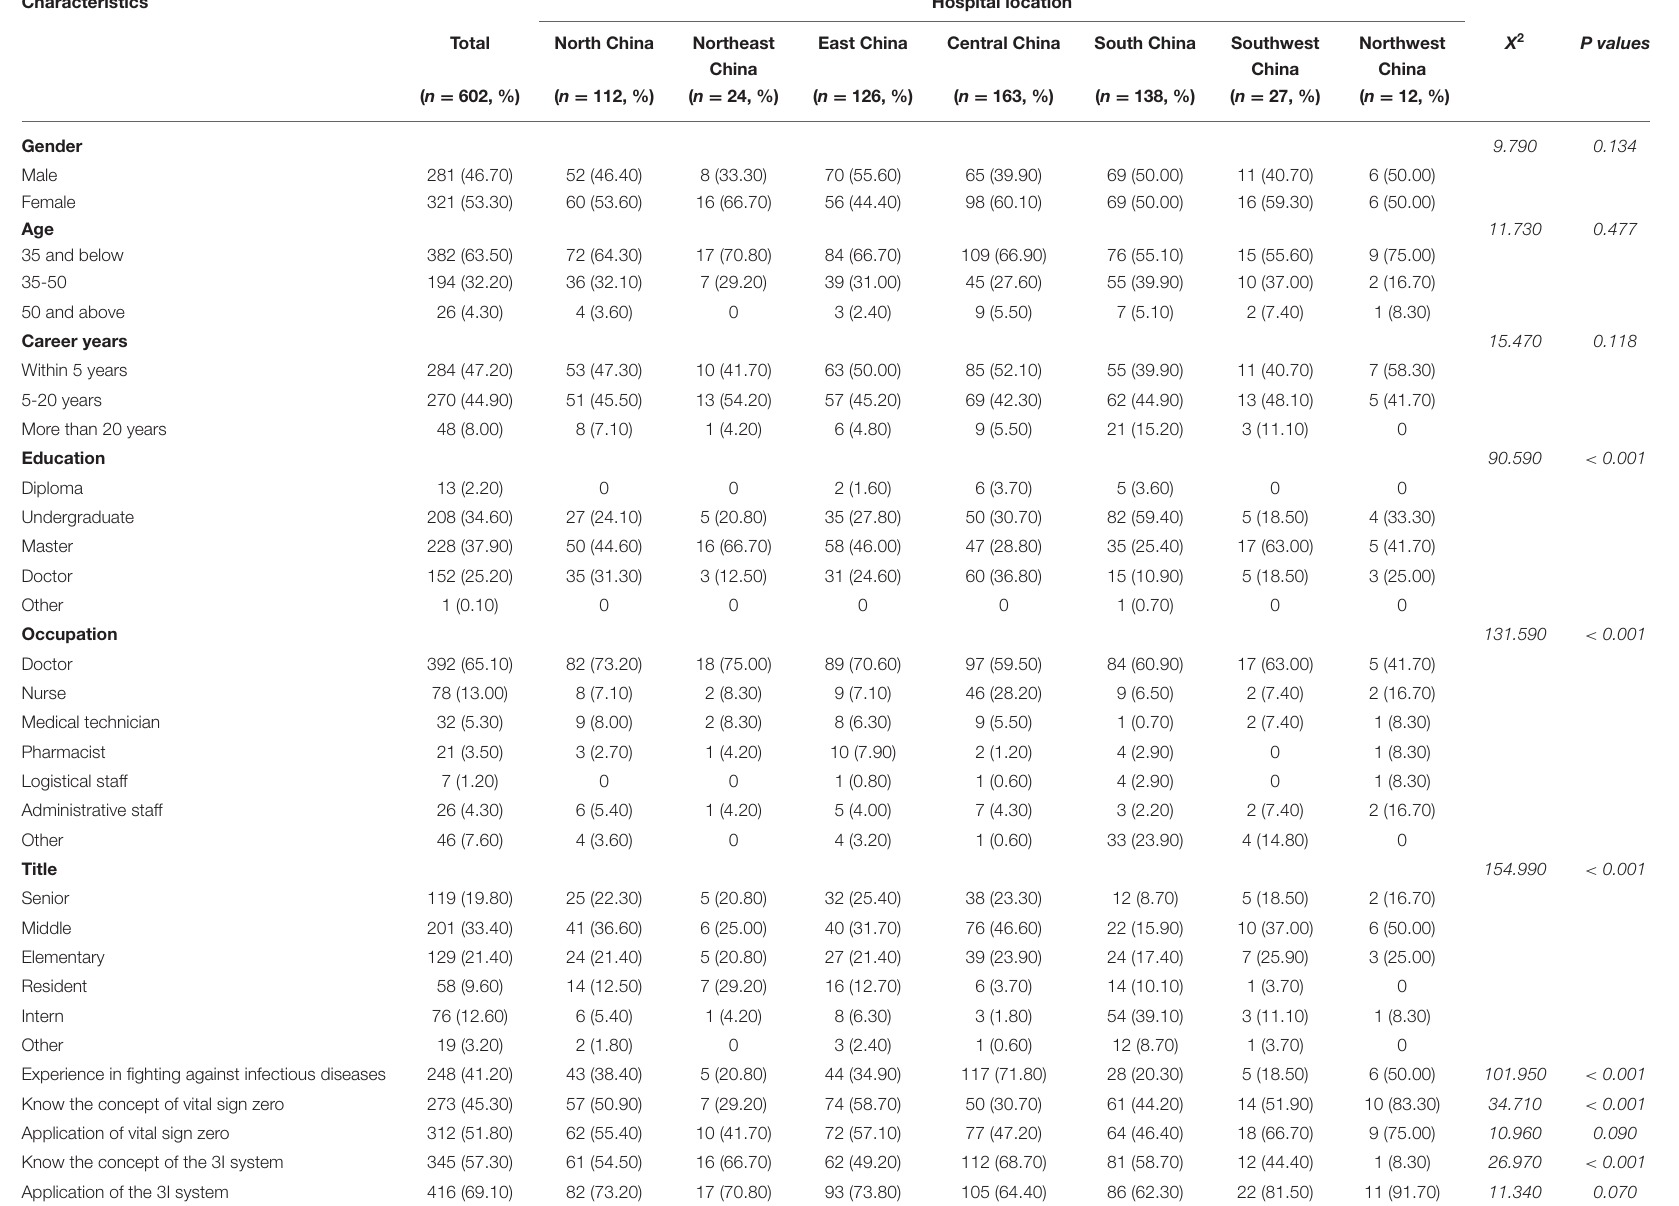
TABLE 2 | Demographic characteristics of participants from tertiary hospitals, China ( n , %).